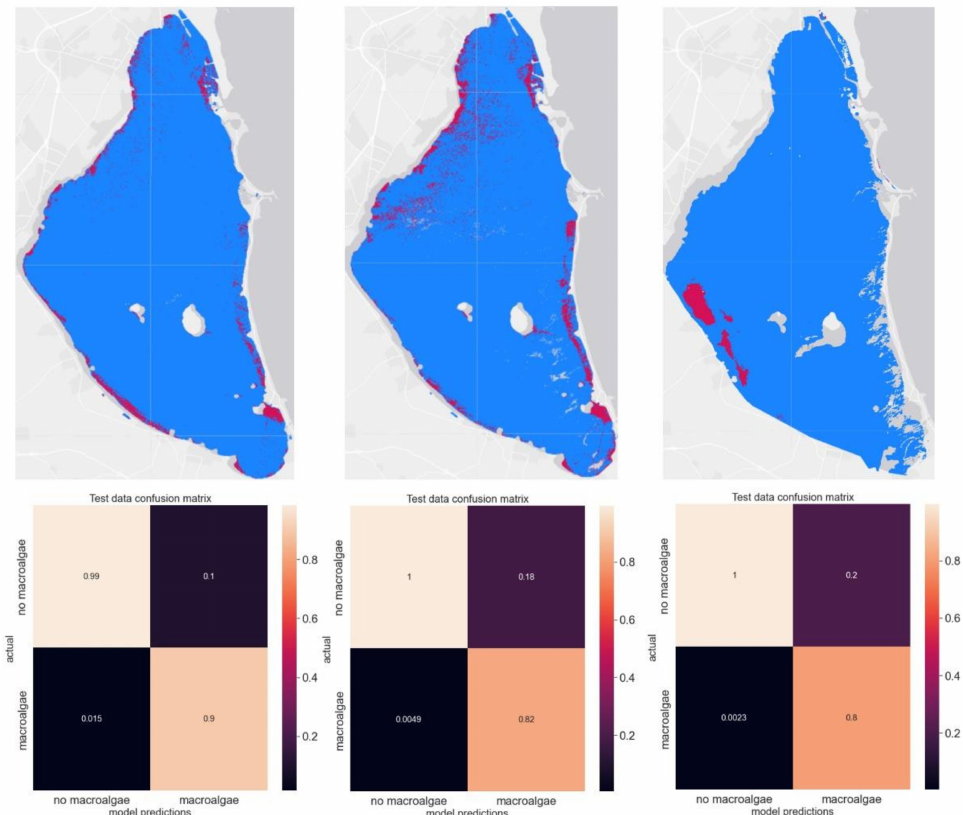
Figure 5. Top panels: classification results. 25 April 2022 ( left ), 10 May 2022 ( center ), 25 May 2022 ( right ). Pink: “macroalgae” class, blue: “no-macroalgae” class. Bottom panels: Confusion matrices for test dataset on 5000 random pixels (not used for training) extracted from images on 25 April 2022 ( left , accuracy = 0.98213, MCC score = 0.78551), 10 May 2022 ( center , accuracy = 0.98406, MCC score = 0.86200), and 25 May 2022 ( right , accuracy = 0.98647, MCC score = 0.86796). The color bar represents the percentage of pixels in a given